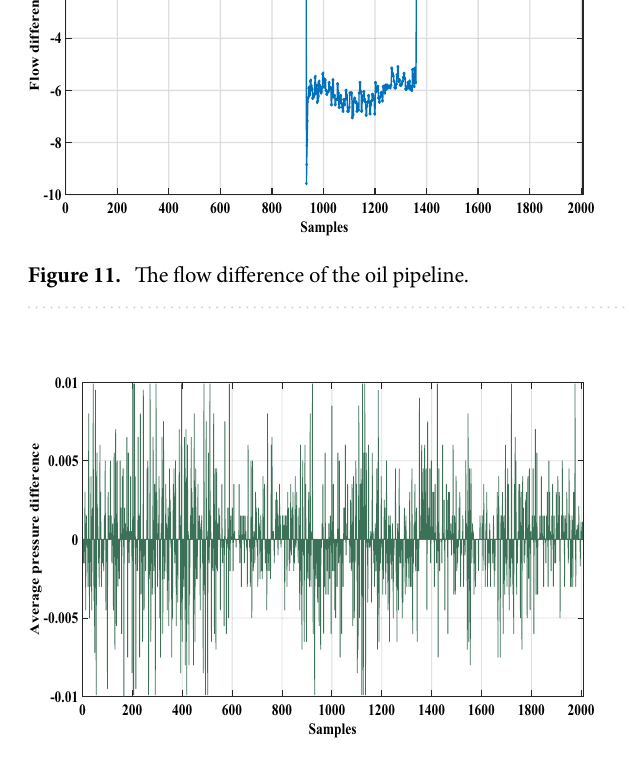
Figure 12. The average pressure difference of the oil pipeline.